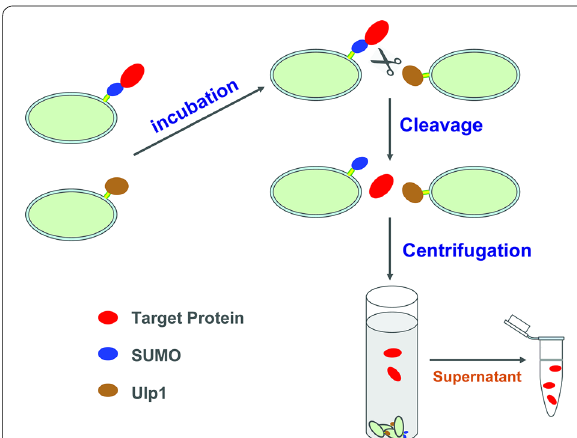
Fig. 1 Illustration of the protein purification strategy based on cell‑surface display of SUMO‑fused recombinant protein and Ulp1